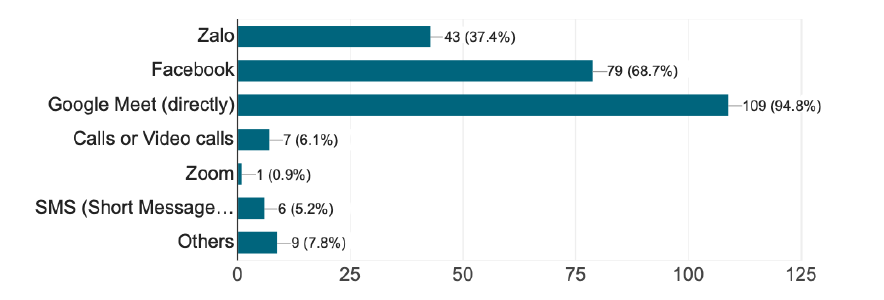
Fig. 3. Participants’ means of interaction with their